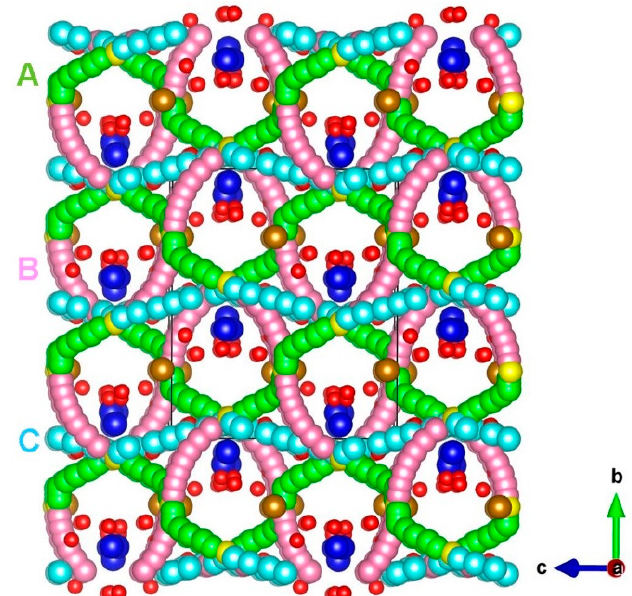
Figure 3. Na ion di ff usion paths calculated in Na 3 Fe 2 (PO 4 ) 3 . Green, purple, and light blue atoms correspond to di ff erent local Na ion hopping trajectories.